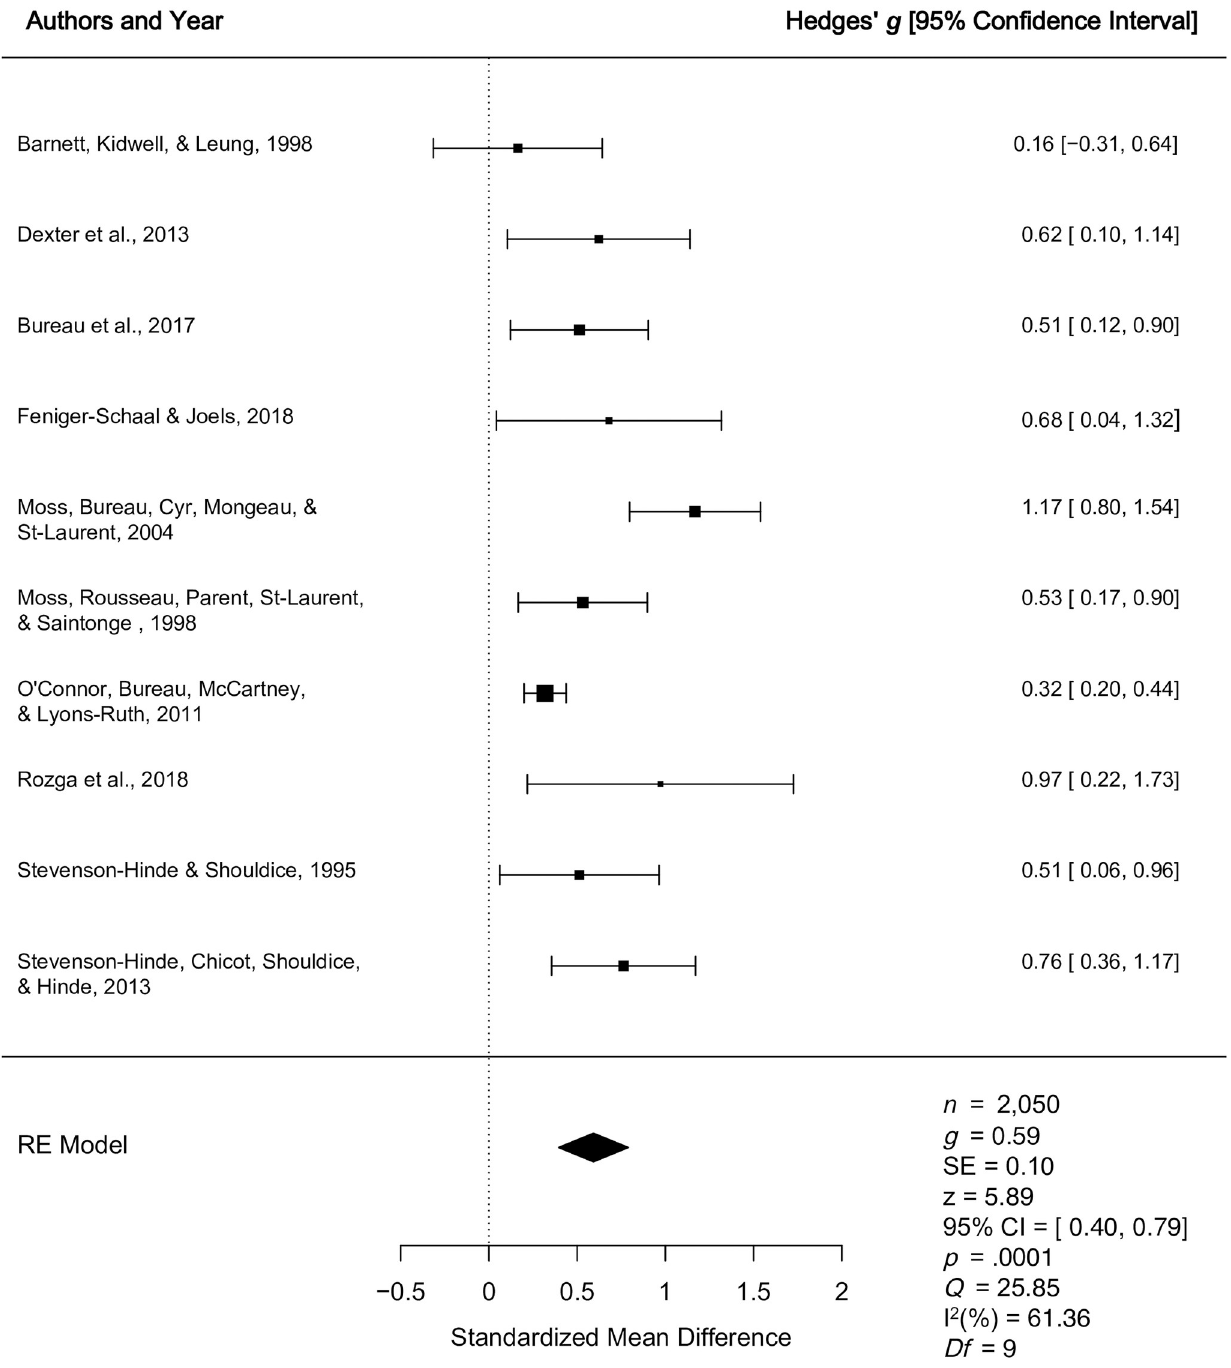
Fig 7. Forest plot for the concurrent relationship between unidimensional caregiver sensitivity and secure versus insecure preschool attachment. RE = Random Effects Model; g = Hedges’ g; Q = Cochran’s heterogeneity statistic; Q; I 2 = percentage of variability across studies that is due to between- study